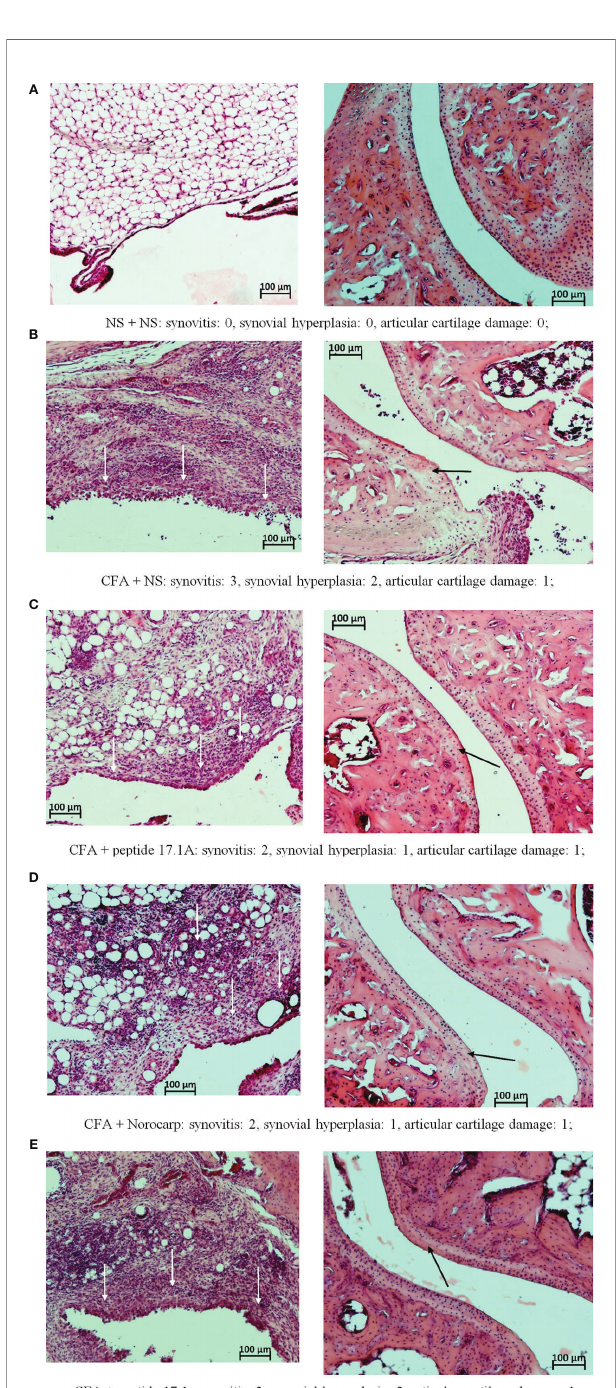
FIGURE 8 | Fragments of the synovial membrane (left column) and the articular surfaces of hyaline cartilage (right column) of the left ankle joint of a mouse at day 21 in the control (A) and in the model of CFA-induced arthritis after injections of normal saline (B) , peptide 17.1A (C) , Norocarp (D) , peptide 17.1 (E) . The severity of synovitis and synovial hyperplasia (white arrows), as well as articular cartilage damage (black arrows) were assessed semi- quantitatively. H&E staining. Magni fi cation